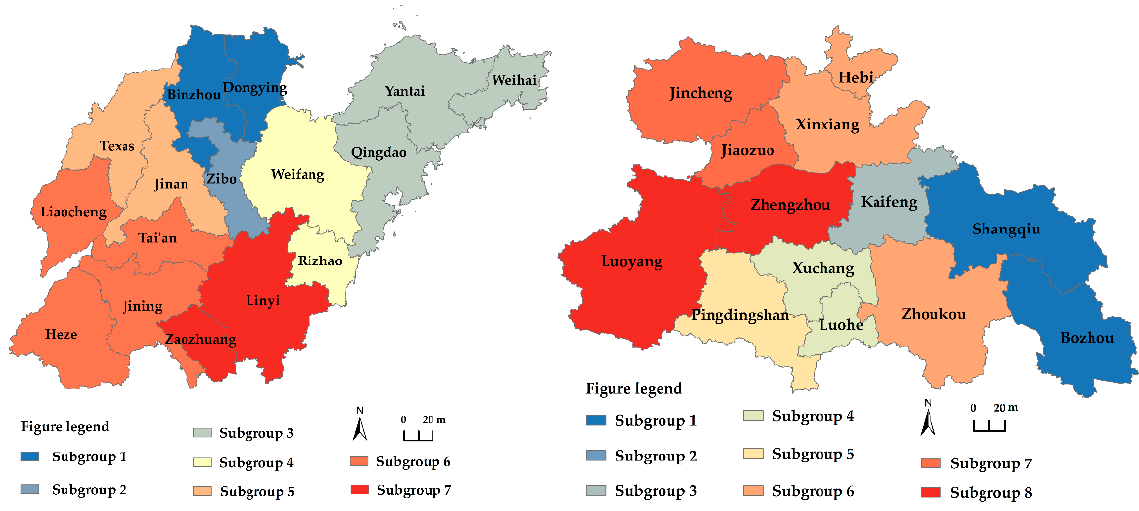
Analysis of coherent subgroups of carbon emission efficiency. Ucinet software was used to conduct a block model analysis based on the correlation matrix of carbon emission efficiency for each city group in 2019. Figure 8 depicts the findings of the cohesive subgroups of the two main urban clusters, and Figure 9 shows the simplified “like matrix”. (1) Prominent subgroups: For instance, Zibo is the lone member of subgroup 2 of the Shandong Peninsula city cluster. Zibo is the industry leader in both input and output carbon emission efficiency and plays a crucial role. (2) The Bridge subgroup, such as Central plains city cluster 1 subgroup. As a representative, Shangqiu has a two-way communication connection with the main subgroup and is closely linked to Kaifeng and Jiaozuo. (3) For the net input subgroup: Pingdingshan, due to its proximity to the carbon emission efficiency subgroup, with Zhengzhou as the core. This subcluster’s resource components are more appealing to the subclusters that surround it. Their linkages are thus unidirectional, and the net output sub-group input impact is less than the output effect. In conclusion, the aforementioned subgroups have distinct tasks and labor divisions. Consequently, the network architectures of the two main urban clusters are notably different, although the characteristics of intra-city cluster links are identical to those of the overall linkages.